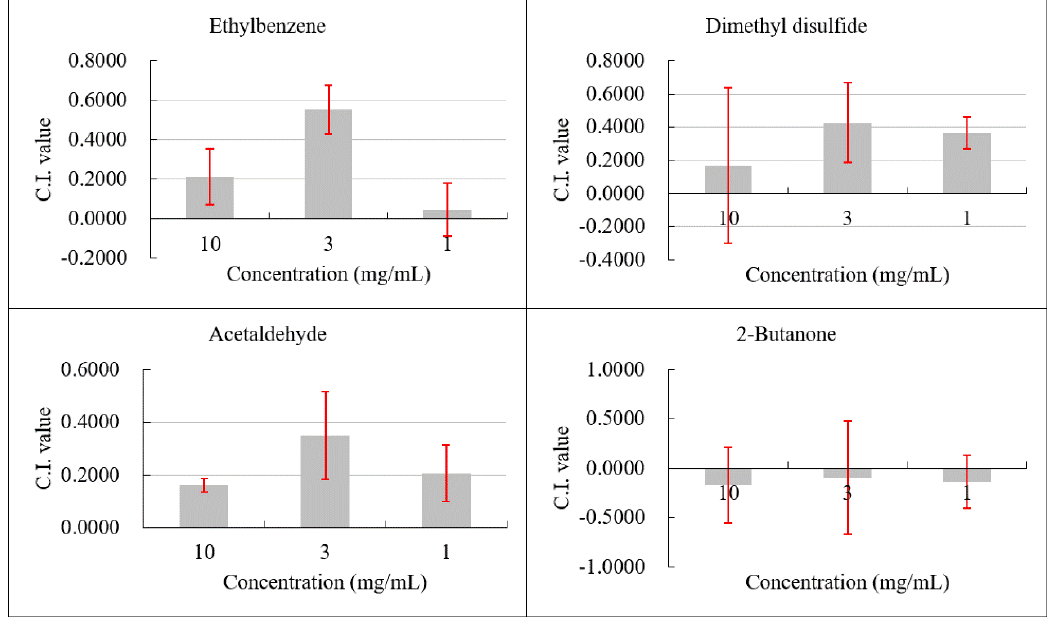
Figure 4. Attracting effect of VOCs on M. incognita .